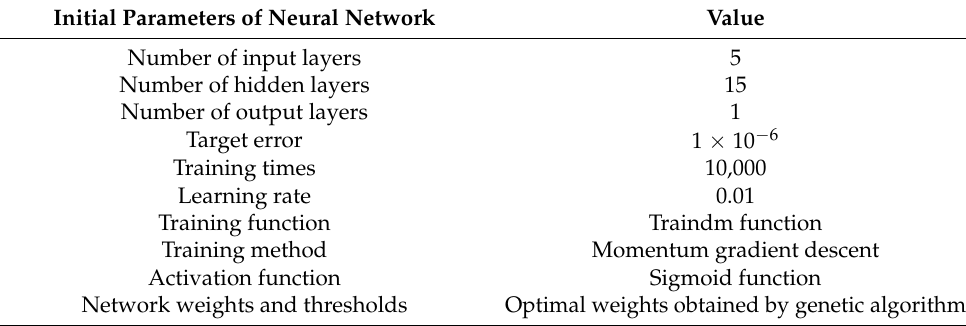
Table 2. Parameters of neural network.